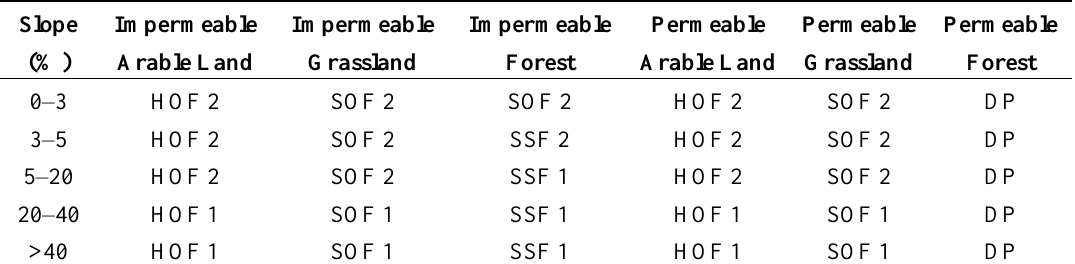
Table 5. GIS-DRP table extreme events